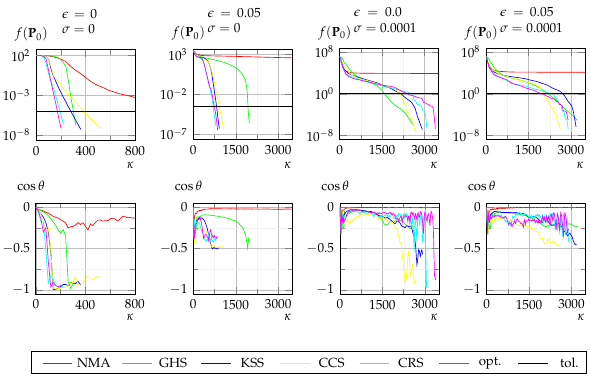
Figure 6. Best objective function values ( f ( P 0 ) ) and corresponding descent rates (cos θ ) during Nelder–Mead run for n p = 100-dimensional GH benchmarks. Tolerance-based algorithm termination applied ( Tol f = Tol X = 10 − 4 ). Black line represents convergence boundary (7) for τ = 10 − 7 .